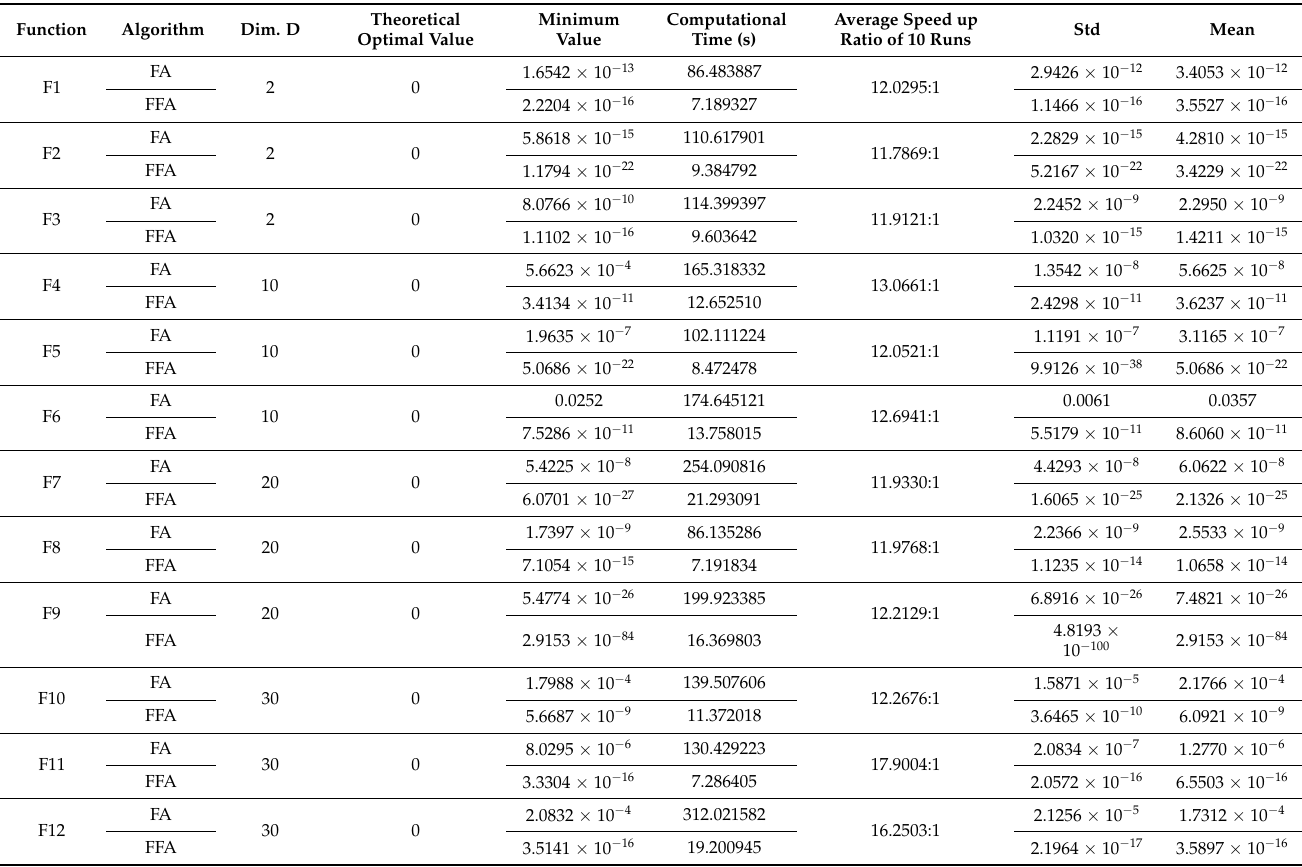
Table 3. Comparative simulation results of FA and FFA for the 12 benchmark test